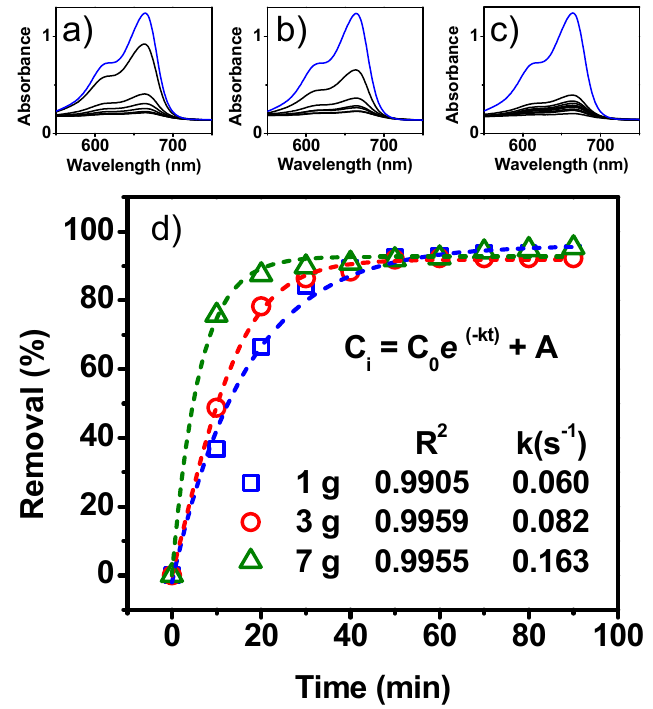
Figure 5. Evaluation of amounts of CT- Sargassum spp. in methylene blue removal: ( a , b , c ) UV-Vis spectra using 1, 3 and 7 g of CT- Sargassum spp., respectively. ( d ) Methylene blue removal rate curves.